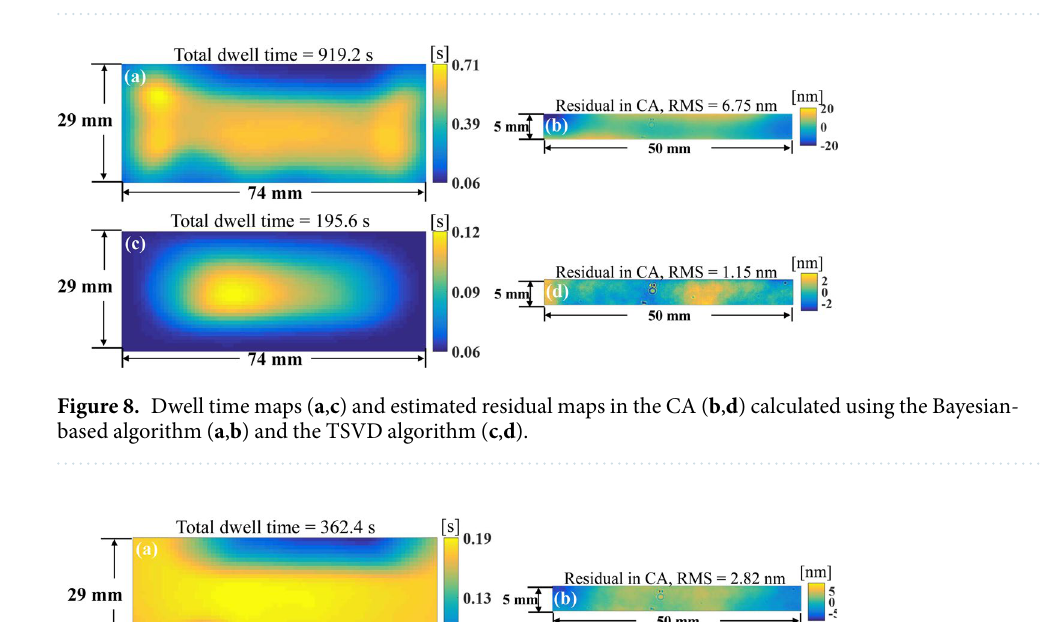
Figure 7. ( a ) Surface error map of a silicon circular flat mirror; ( b ) the error maps in the dwell grid (DG) and the clear aperture (CA); and ( c ) the beam removal function obtained from the bombarded ion beam footprints.